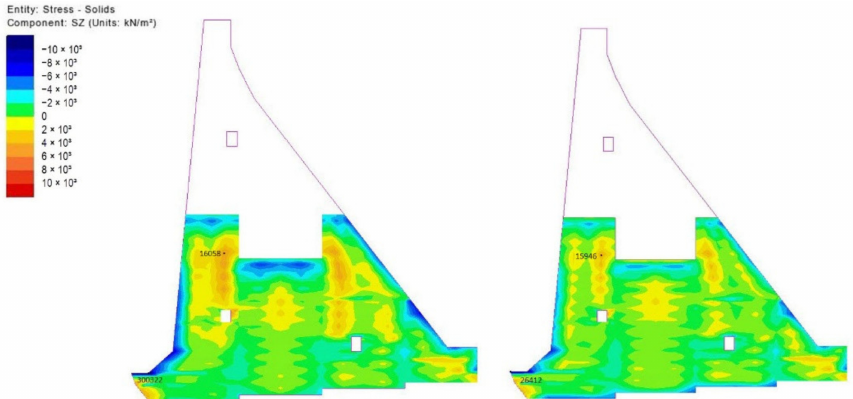
Figure 20. Stresses σ z in the mid-plane of the monolith 20 m long ( left ) and 15 m long ( right ) for the 283rd day (27th of July of the second year); extremums: nodes 16,058 and 15,946.